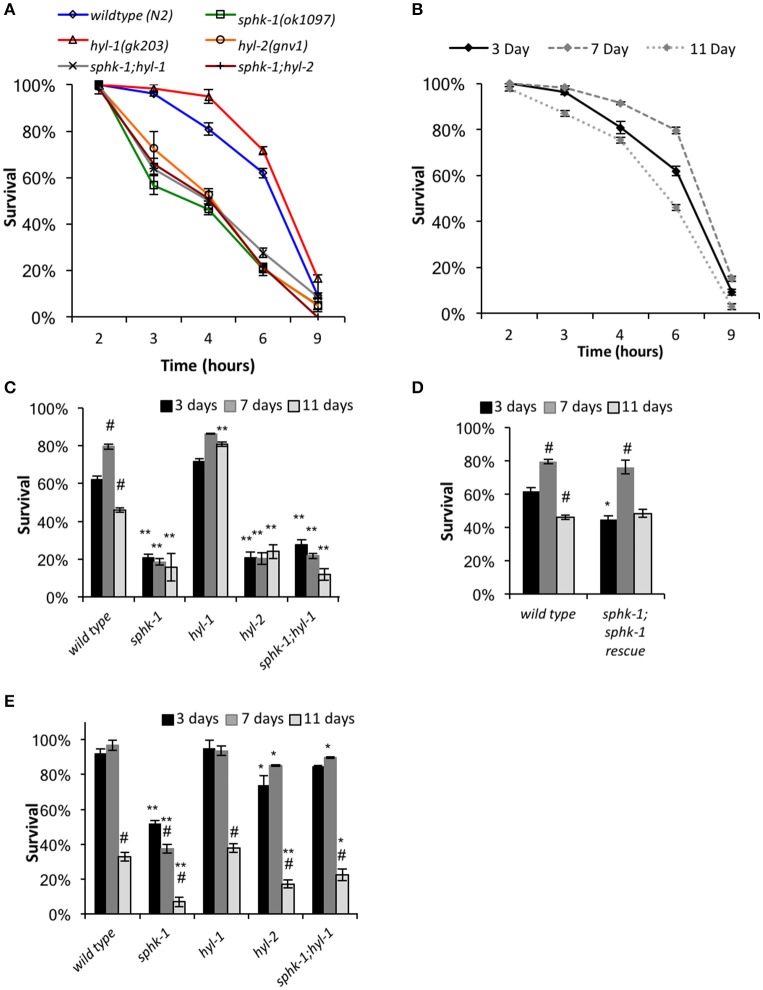
Response to heat stress is influenced by sphingolipid enzymes and age. (A) Chronic heat stress assay on the indicated animals. Wild type and mutant animals were exposed to 35°C (from room temperature) and the fraction of survival was tallied at the times indicated. (B) Wild type animals of different ages responded differently to heat stress. (C,D) Fraction of survival of wild type and indicated mutants at 3, 7, or 11 days old exposed to 35°C at the 6 h time point. (E) Response of animals to an acute heat shock assay (37°C for 90 min). Fraction of survival of wild type and indicated mutants is shown at 3, 7, or 11 days old. For all, error bars are ± SEM, *p < 0.01 and **p < 0.001 for comparisons to the wild type counterpart, and #p < 0.01 for comparisons to the 3 day old counterpart.